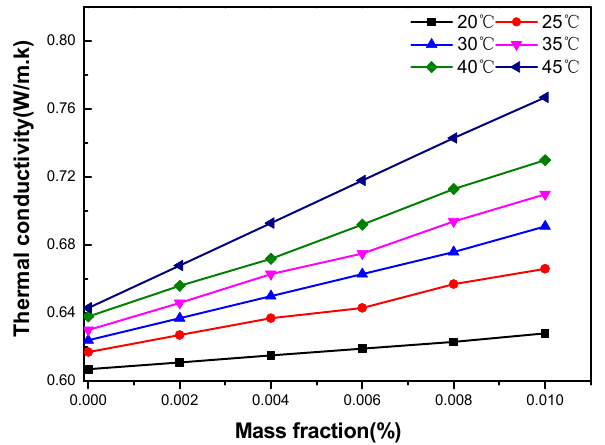
Figure 6. Thermal conductivity of GO–water nanofluid versus mass fraction at various tempera- tures.